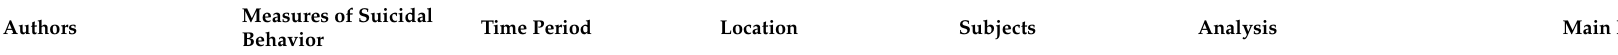
Table 1. Articles selected for the literature review of the GEJE and suicide and suicide prevention